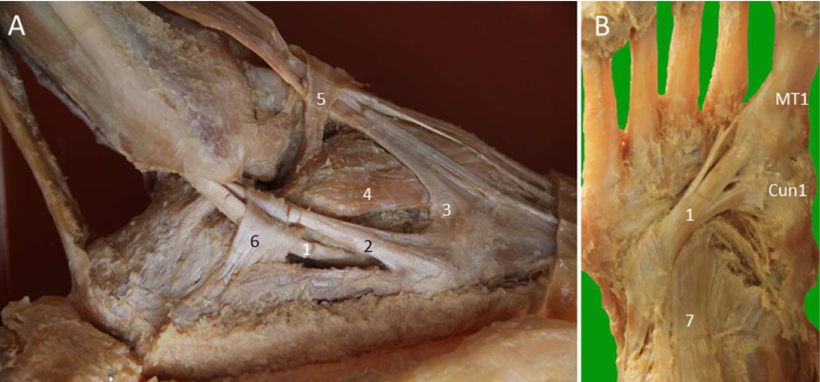
Figure 19. Cadaveric models for the peroneal tendons at the lateral ankle ( A ) and the peroneus longus tendon at the plantar aspect ( B ). 1: Peroneus longus tendon; 2: peroneus brevis tendon; 3: peroneus tertius tendon; 4: extensor digitorum brevis muscle; 5: frondiform ligament of the inferior extensor retinaculum; 6: inferior peroneal retinaculum; 7: long plantar ligament. Cun1: medial cuneiform; MT1: first metatarsal